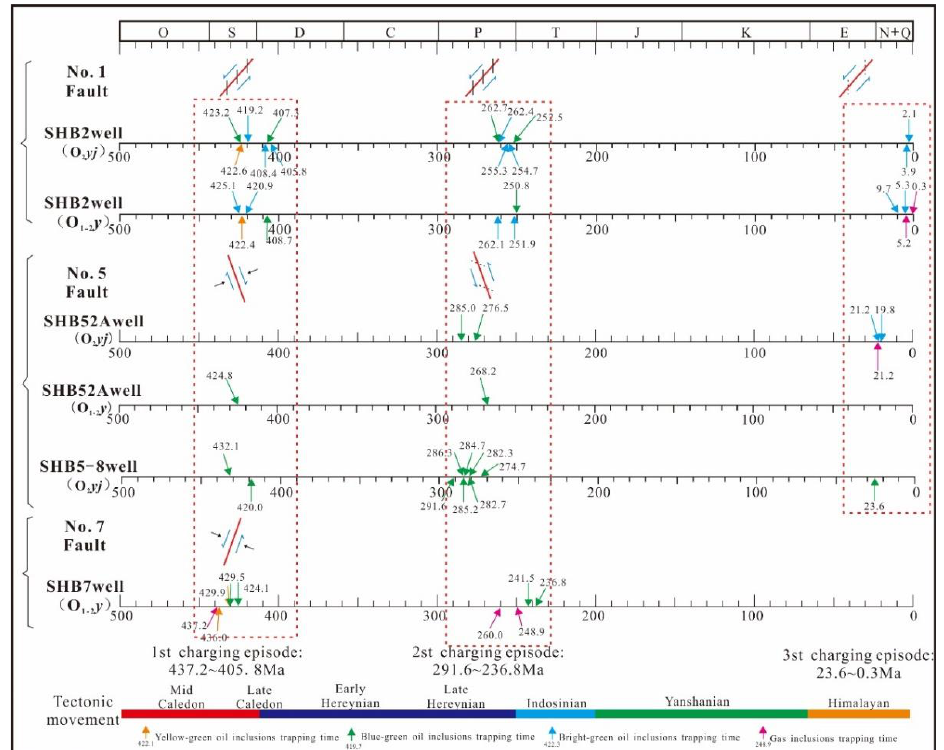
Figure 9. Composite results showing hydrocarbon charge timing in the Yijianfang and Yingshan reservoir Formations in the Shunbei